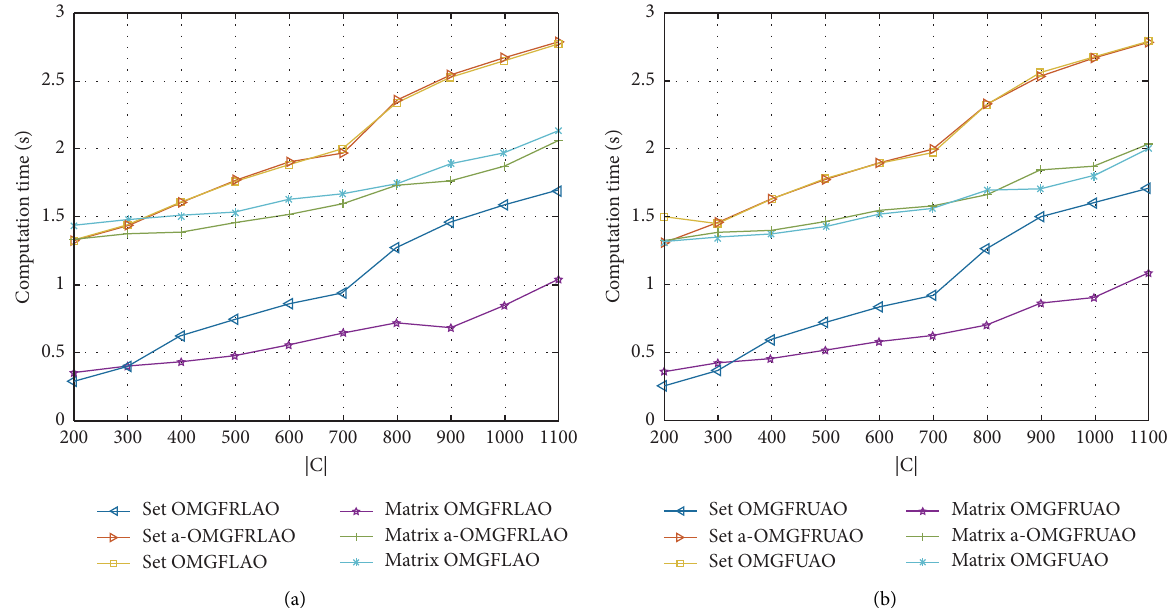
Figure 3: Computational time of matrix methods and set methods with diferent sizes of 􏽢 C ( β � 0 . 5 , | U | � 500 ) . (a) Comparison of matrix methods and set methods of lower approximation operators with diferent sizes of 􏽢 C . (b) Comparison of matrix methods and set methods of upper approximation operators with diferent sizes of 􏽢 C